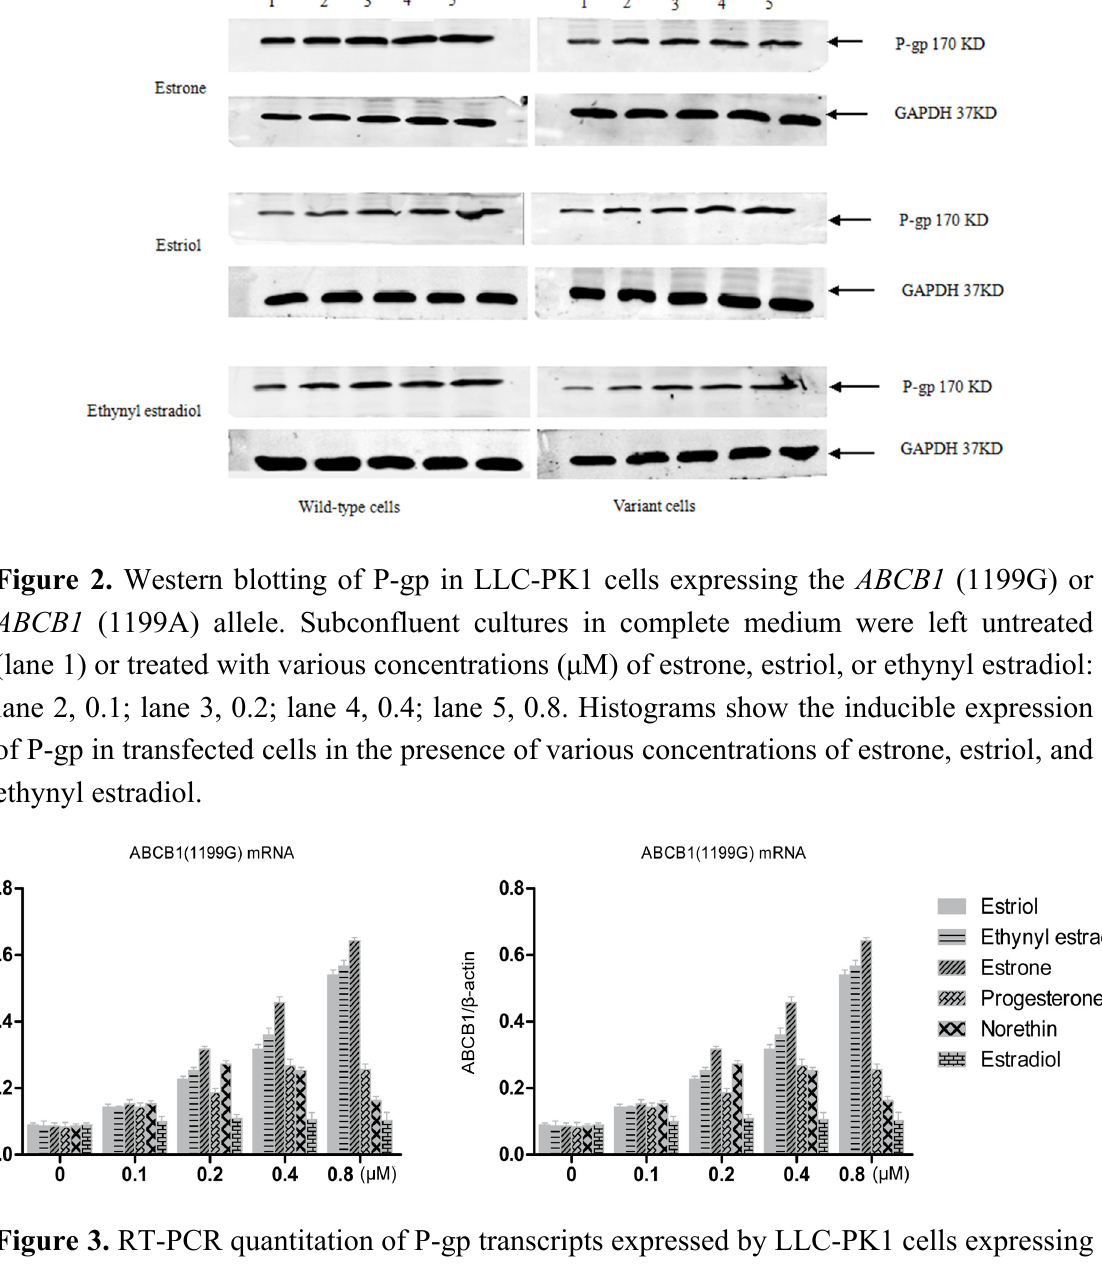
Figure 3. RT-PCR quantitation of P-gp transcripts expressed by LLC-PK1 cells